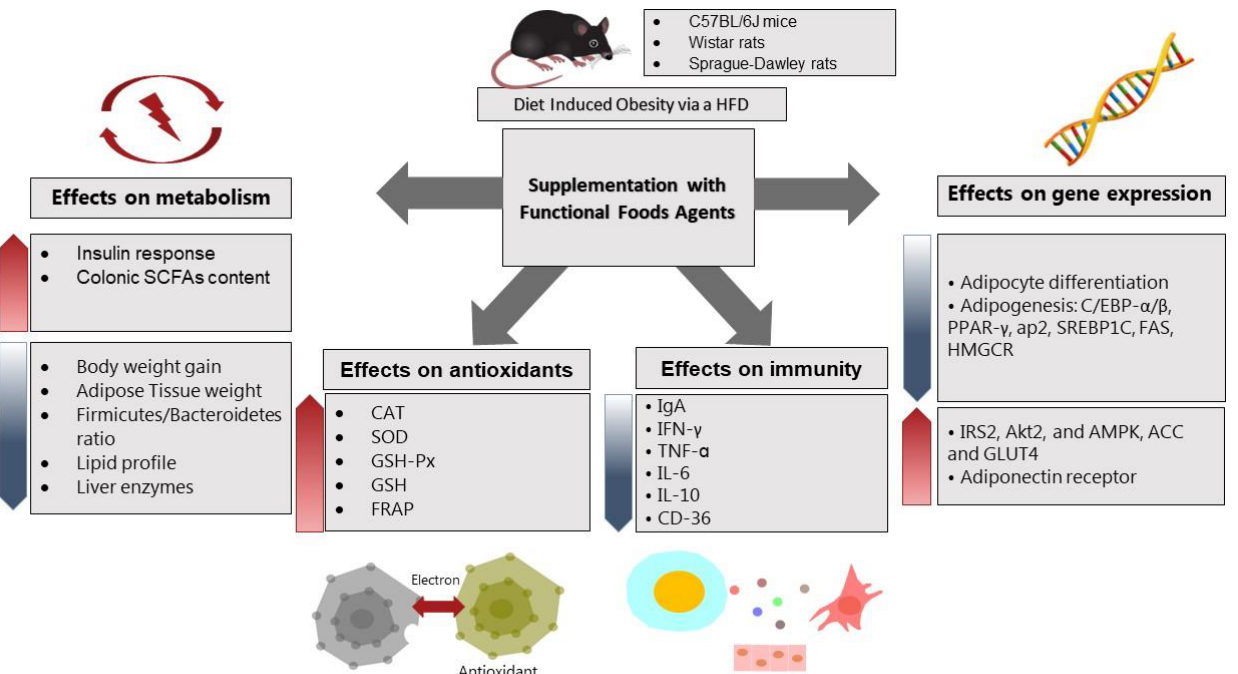
Figure 2. The effects of various fermented foods on metabolism, antioxidant status, immunity, and gene expression of metabolic factors in three different animal models. Abbreviations: SCFAs: short chain fatty acids, CAT: catalase, SOD: superoxide dismutase, GSH-PX: glutathione peroxidase, GSH: glutathione, FRAP: fluorescence recovery after photobleaching, IgA: immunoglobulin A, IFN- γ : interferon- γ , TNF- α : tumor necrosis factor- α , IL-6: interleukin-6, IL-10: interleukin-10, CD-36: cluster of differentiation-36, C/EBP- α / β : CCAAT/enhancer-binding protein- α / β , PPAR- γ : peroxisome proliferator-activated receptor- γ , AP-2: adaptor protein complex-2, SREBP-1c: sterol regulatory element-binding transcription factor 1, FAS: Fas cell Surface death receptor, HMGCR: HMG-CoA reductase, IRS-2: insulin receptor substrate 2, AKT-2: serine/threonine kinase, AMPK: AMP-activated protein kinase, ACC: acetyl-CoA carboxylase, GLUT4: insulin-regulated glucose trans- porter.